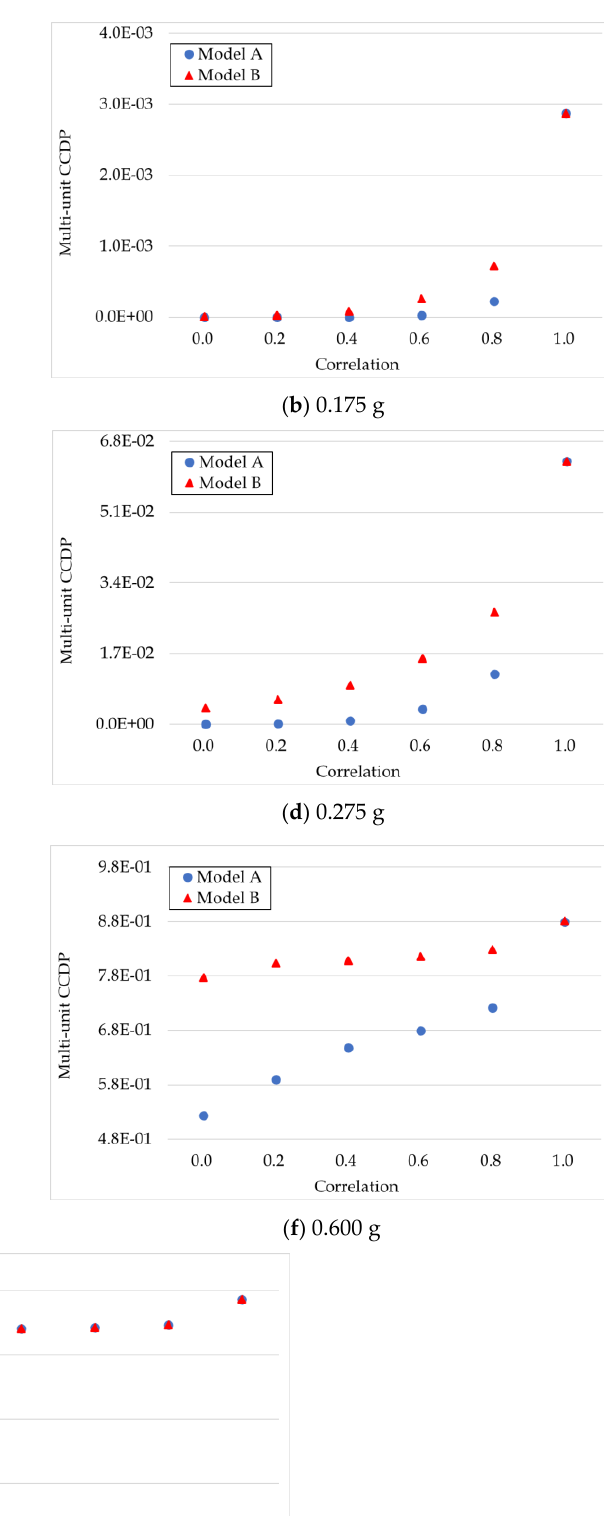
Figure 14. Plots of MUCDF versus seismic correlation.